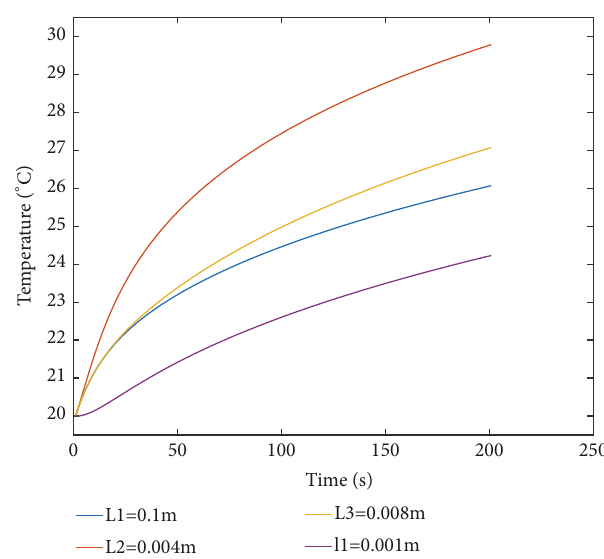
Figure 7: The temperature field in the t=200s.